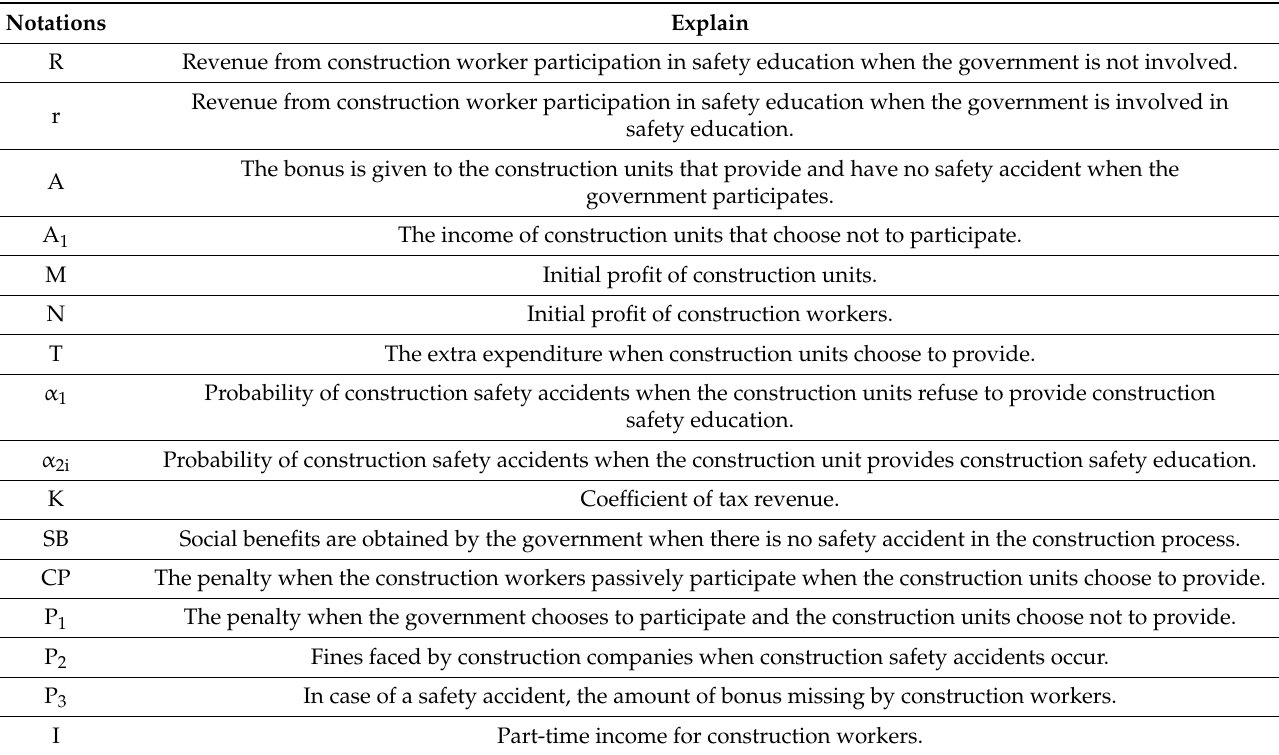
Table 1. Summary of notations.